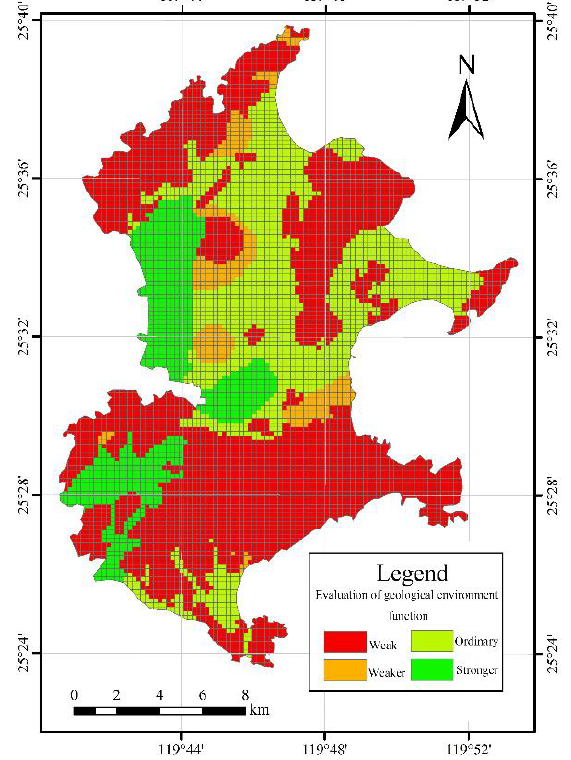
Figure 7. Assessment results of groundwater geology environment function in the study area.